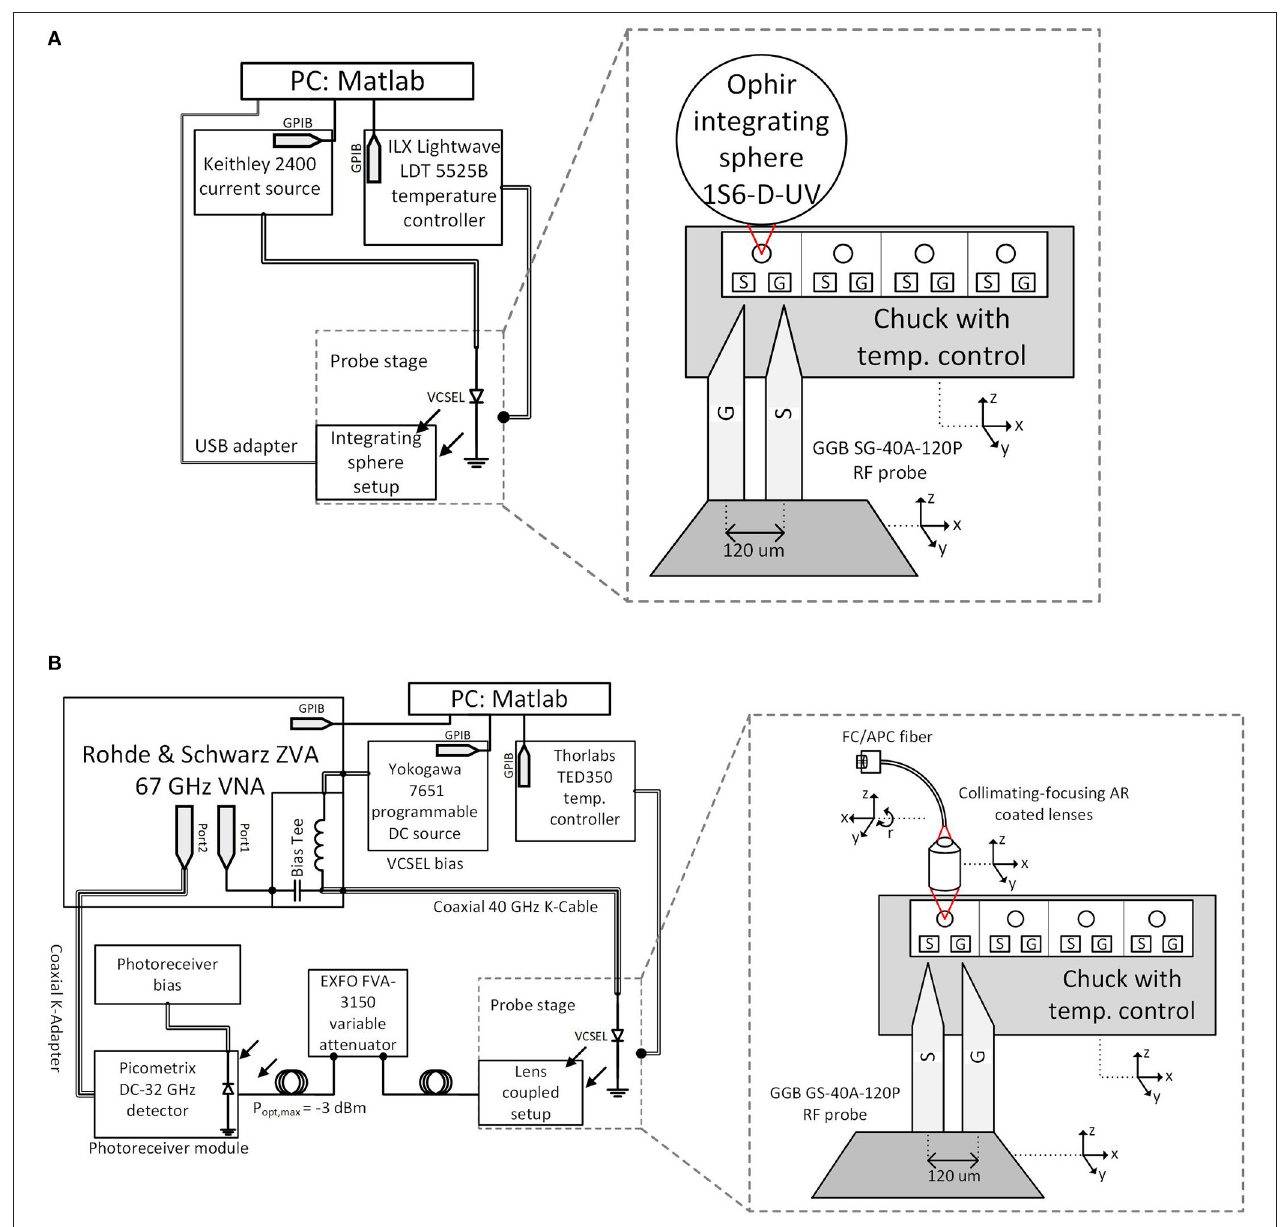
FIGURE 7 | Characterization setups for the VCSEL. (A) Test bench for IPV measurements. (B) Test bench for S-parameter